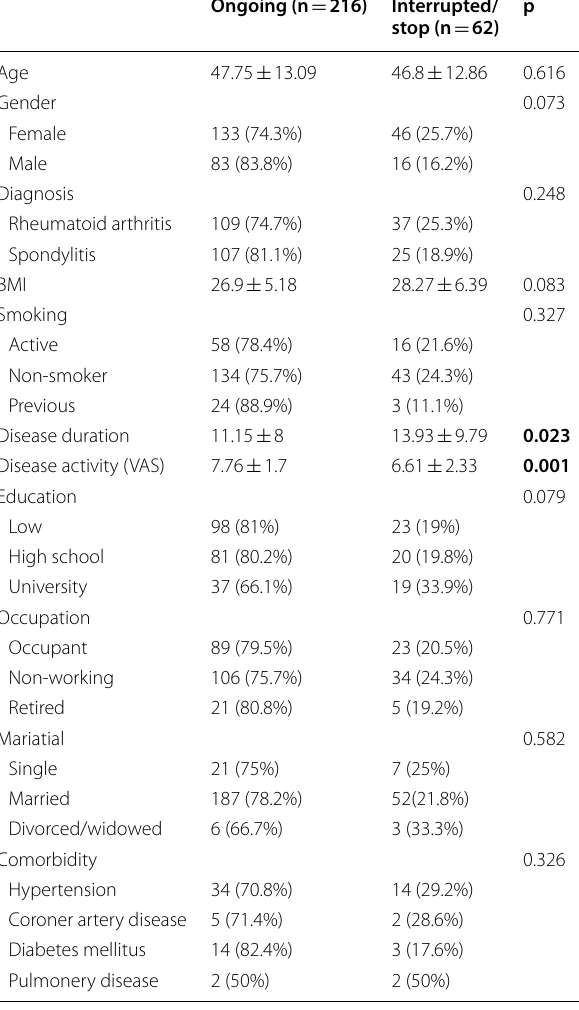
Table 1 Comparison of the demographic variables in patients acoording to the contiuation status